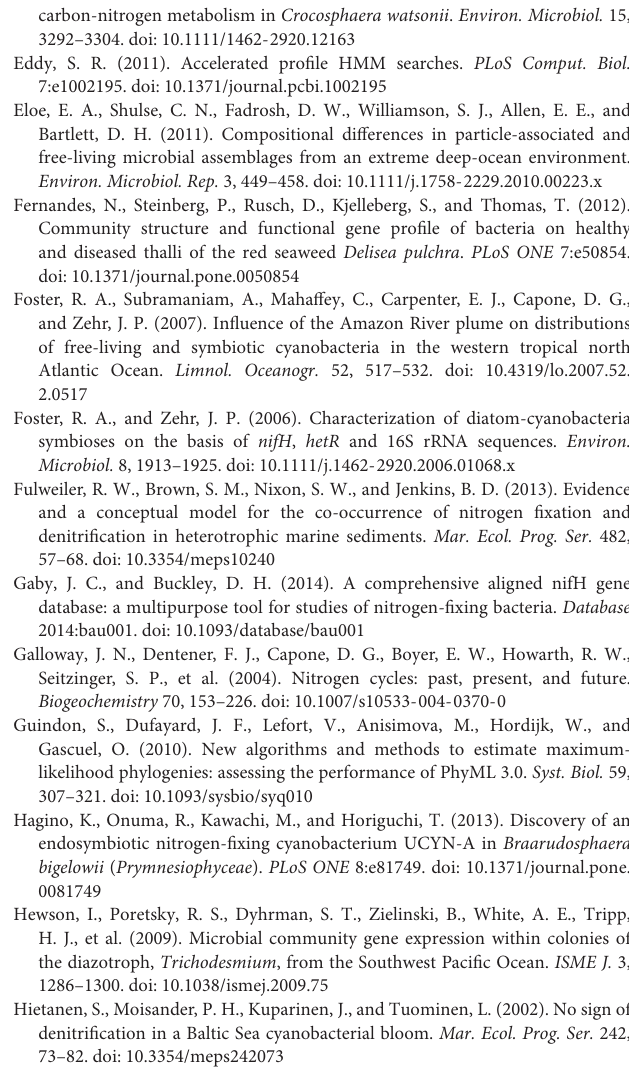
TABLE S1 | Summary of metagenomic data for the unicellular cyanobacteria GB-CYN1. Analysis includes assignment of phylogenetic marker genes to GB-CYN1 and analysis of genes from different metabolic pathways of interest. TABLE S2 | Summary of metagenomic analysis of marker genes for nitrate and nitrite